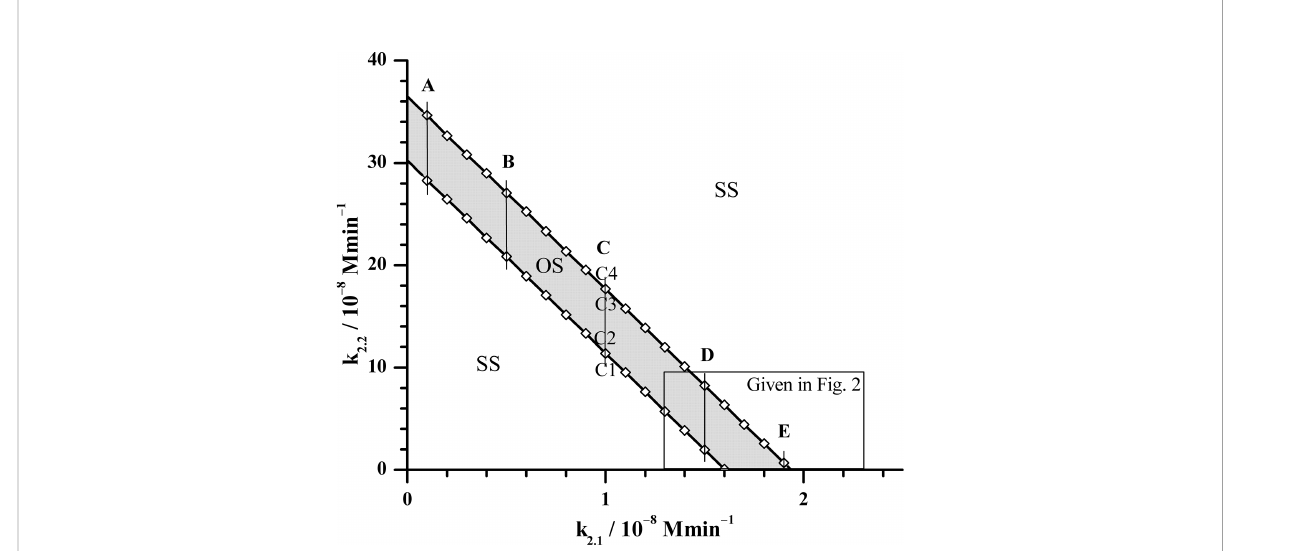
FIGURE 1 Position of supercritical AH bifurcation as a function of rate constants k 2.1 and k 2.2 , obtained by Method 1a of bifurcation analysis for k 5.3 = 3.66 × 10 2 mol − 1 dm 3 min − 1 (the value given in Table 1). The calculated AH bifurcations, depicted by open rhombuses ( ◊ ) are interconnected by solid lines for better visualization of the oscillatory domain. OS - oscillatory domain; SS - stable steady states. Five fi xed k 2.1 values denoted as cases: A (k 2.1 = 0.1 × 10 − 8 mol dm − 3 min − 1 ), B (k 2.1 = 0.5 × 10 − 8 mol dm − 3 min − 1 ), C (k 2.1 = 1.0 × 10 − 8 mol dm − 3 min − 1 ), D (k 2.1 = 1.5 × 10 − 8 mol dm − 3 min − 1 ) and E (k 2.1 = 1.9 × 10 − 8 mol dm − 3 min − 1 ) for which Method 1b was applied near bifurcation points. In the case C, Method 1b was applied in points where values of rate constant k 2.2 are: C1 (k 2.2 = 11.2 × 10 − 8 mol dm − 3 min − 1 ), C2 (k 2.2 = 11.4 × 10 − 8 mol dm − 3 min − 1 ), C3 (k 2.2 = 17.6 × 10 − 8 mol dm − 3 min − 1 ) and C4 (k 2.2 = 18.6 × 10 − 8 mol dm − 3 min − 1 ) (More details will be shown in Figure 3). All other rate constants used in both Method 1a and 1b analysis had values as presented in Table 1, except in Method 1b where k 5.3 was